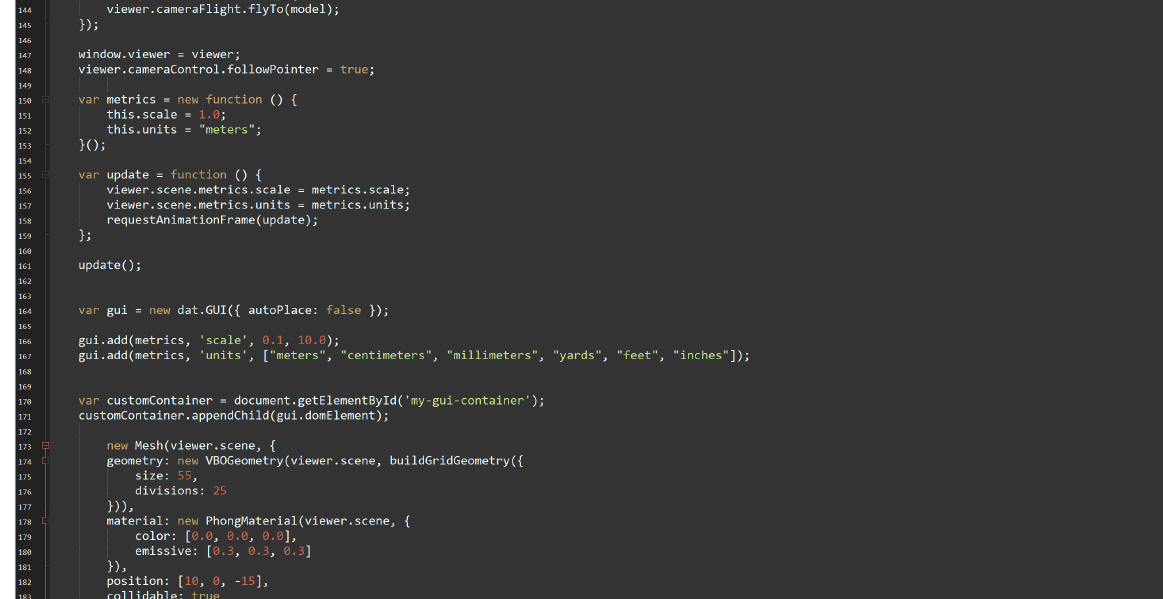
Figure 17. Part of source code related to the Measurements Centre plugin (the complete code is on the ARK-BIM website).